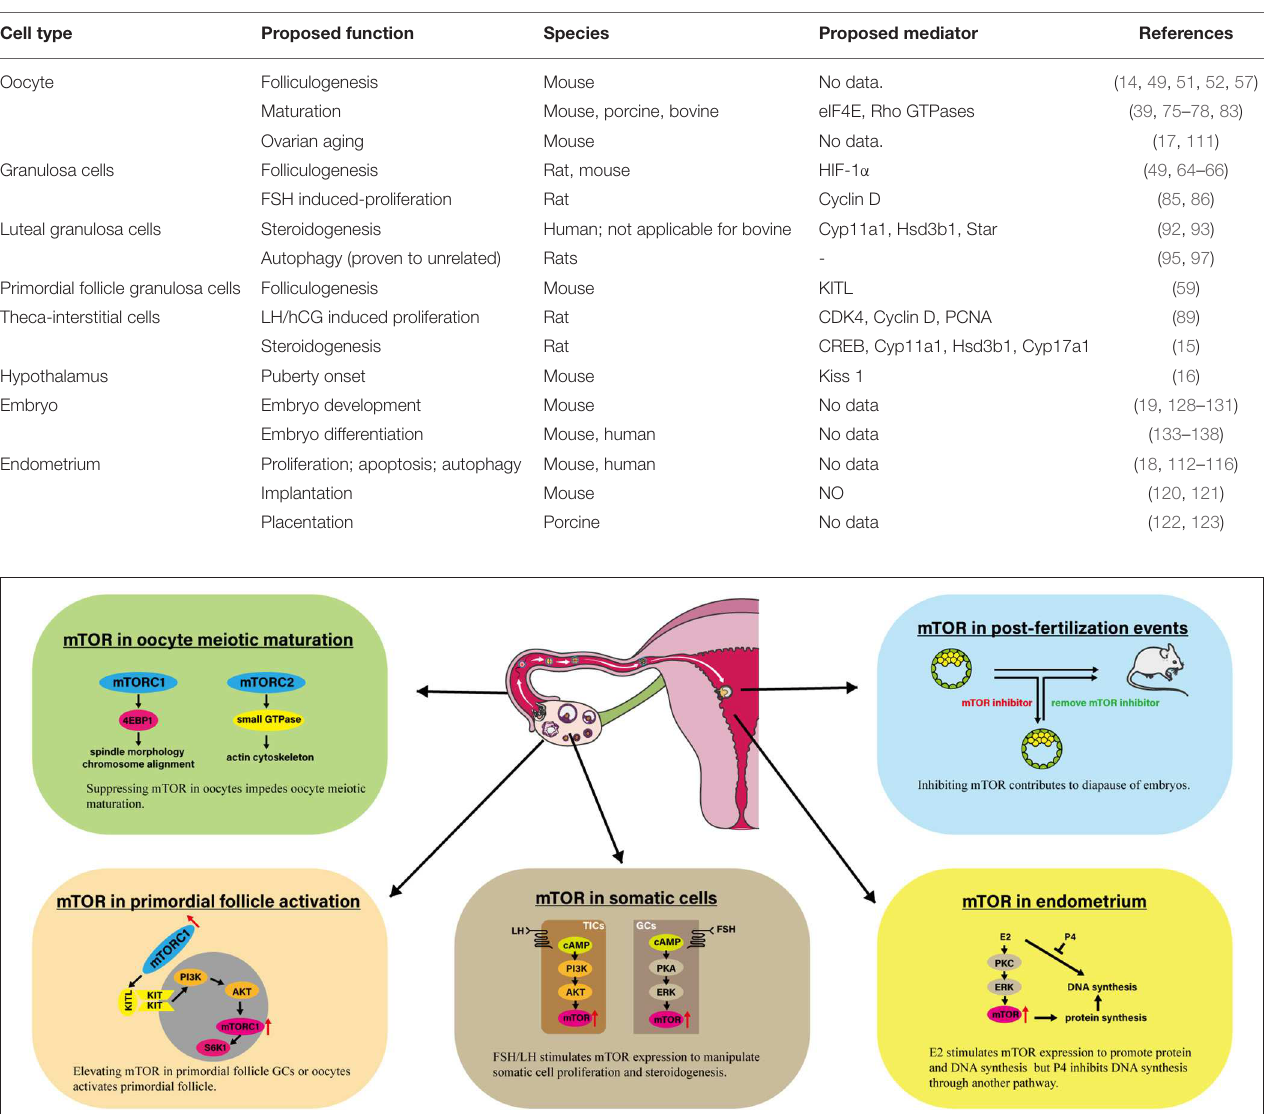
TABLE 2 | Role of mTOR signaling in female reproductive cells and organs.